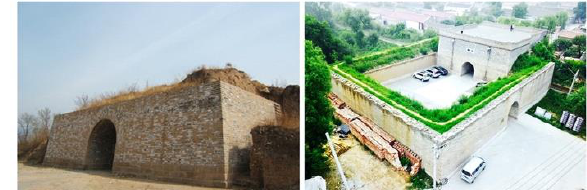
Figure 9. Comparison before and after the repair of the north town